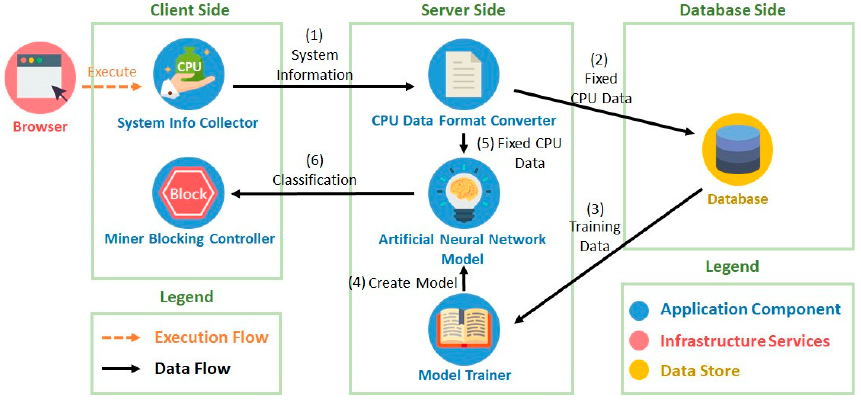
Figure 8. System structure. Figure 8. System